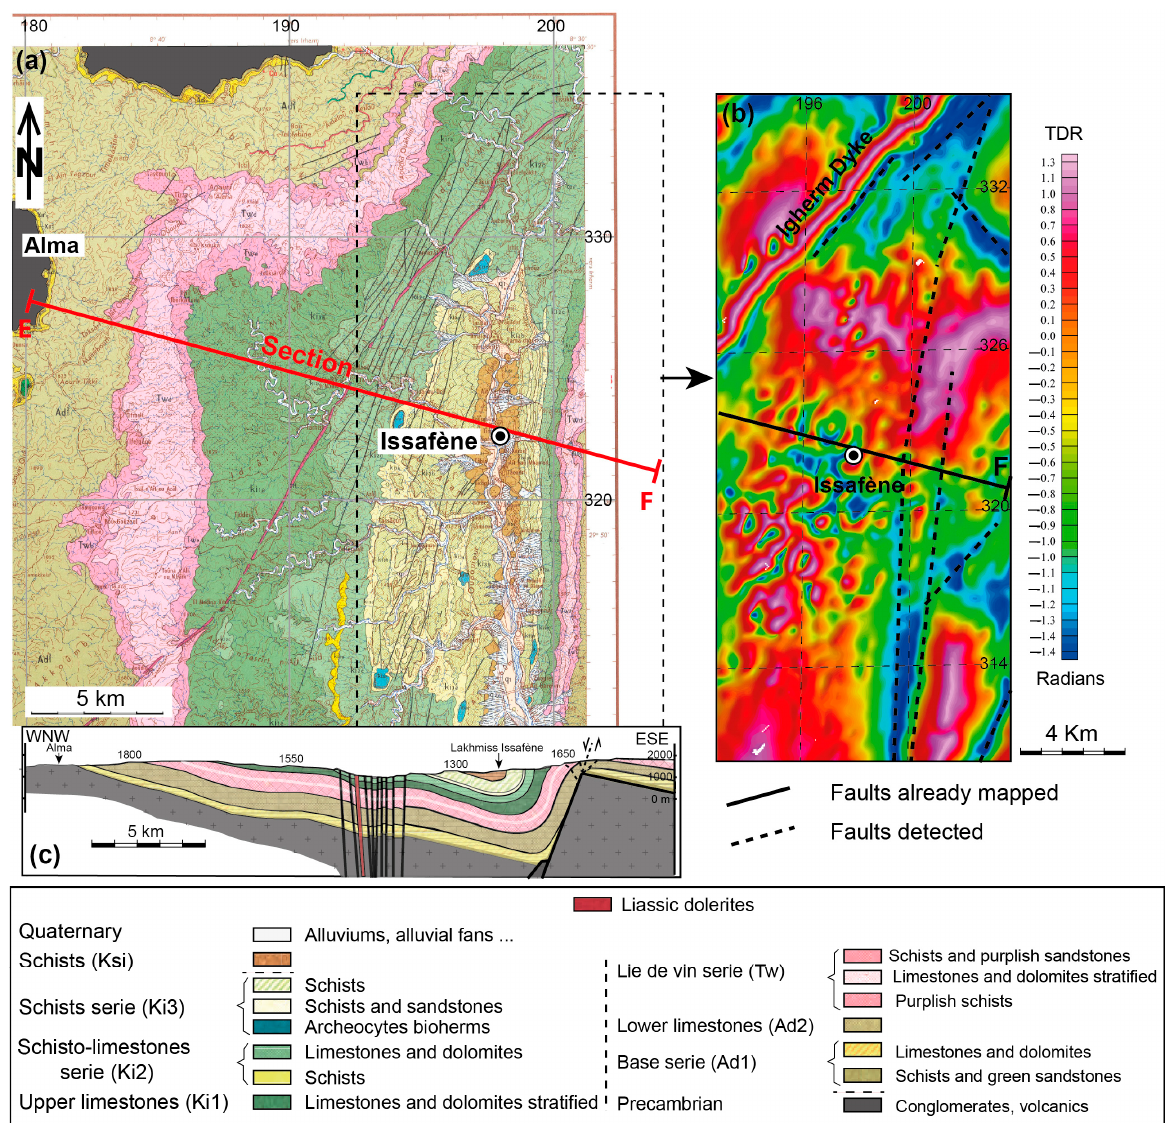
Figure 2. ( a ) Geological map of the Issaf è ne syncline (excerpt from the Tafraout geological map at 1/100,000). ( b ) Map of the residual magnetic field transformed by the “derivative tilt” method of the Issaf è ne region. ( c ) Interpretive geological cross-section (cross-section E-F on a map in Figure